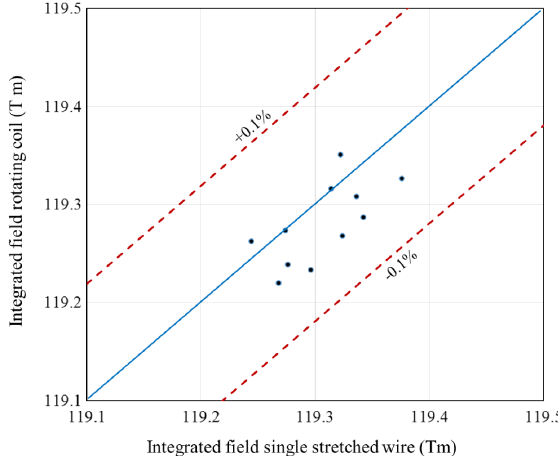
FIG. 3. Comparison between integrated dipole fields measured with single stretched wire and with a rotating coil for 11 LHC dipoles (courtesy of L. Bottura and M. Buzio). The dashed lines correspond to deviations of (cid:1) 0 . 1%